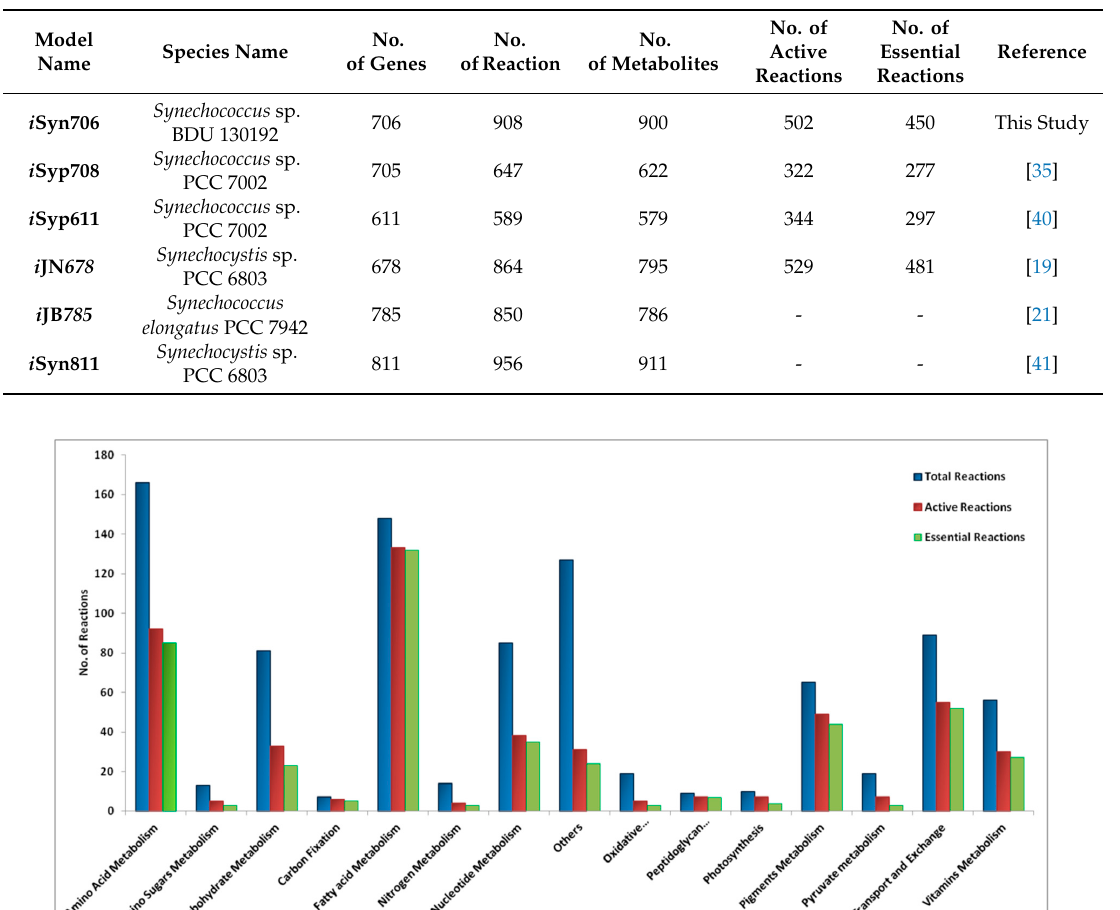
Table 2. Comparison of the i Syn706 model with other published models of cyanobacteria.